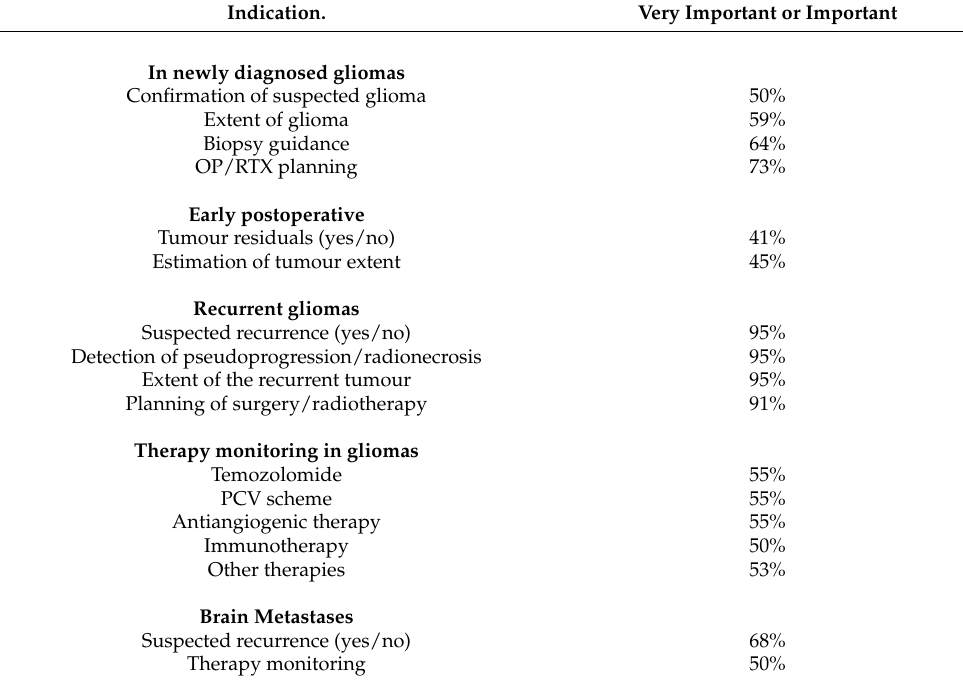
Table 1. Referrers’ rating of the significance of FET PET for different indications.